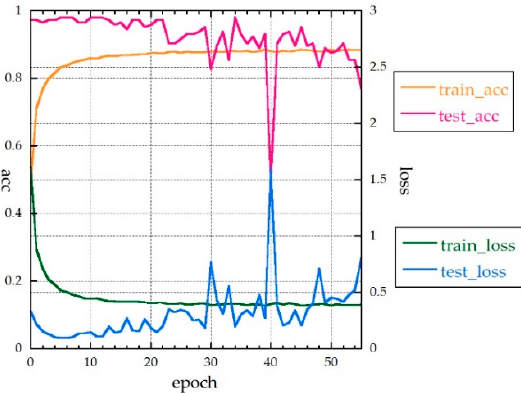
Figure 16. Accuracies and loss function values of CNN2d_HQ.